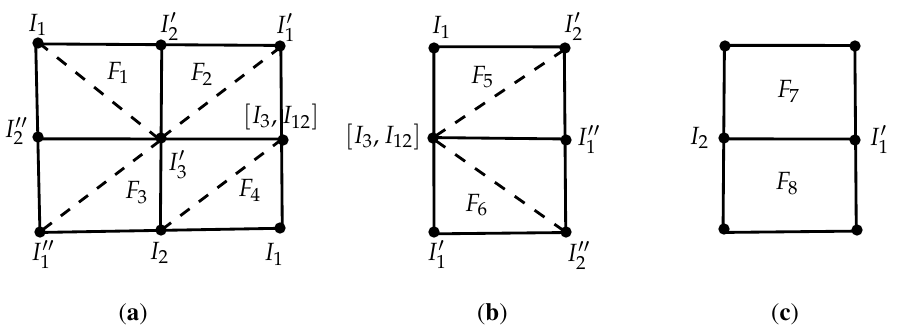
Figure 5. Faces representation of N 2 -embedding of K 4,4 . Figure 5. Representation of faces of N 2 -embedding of K 4,4 .